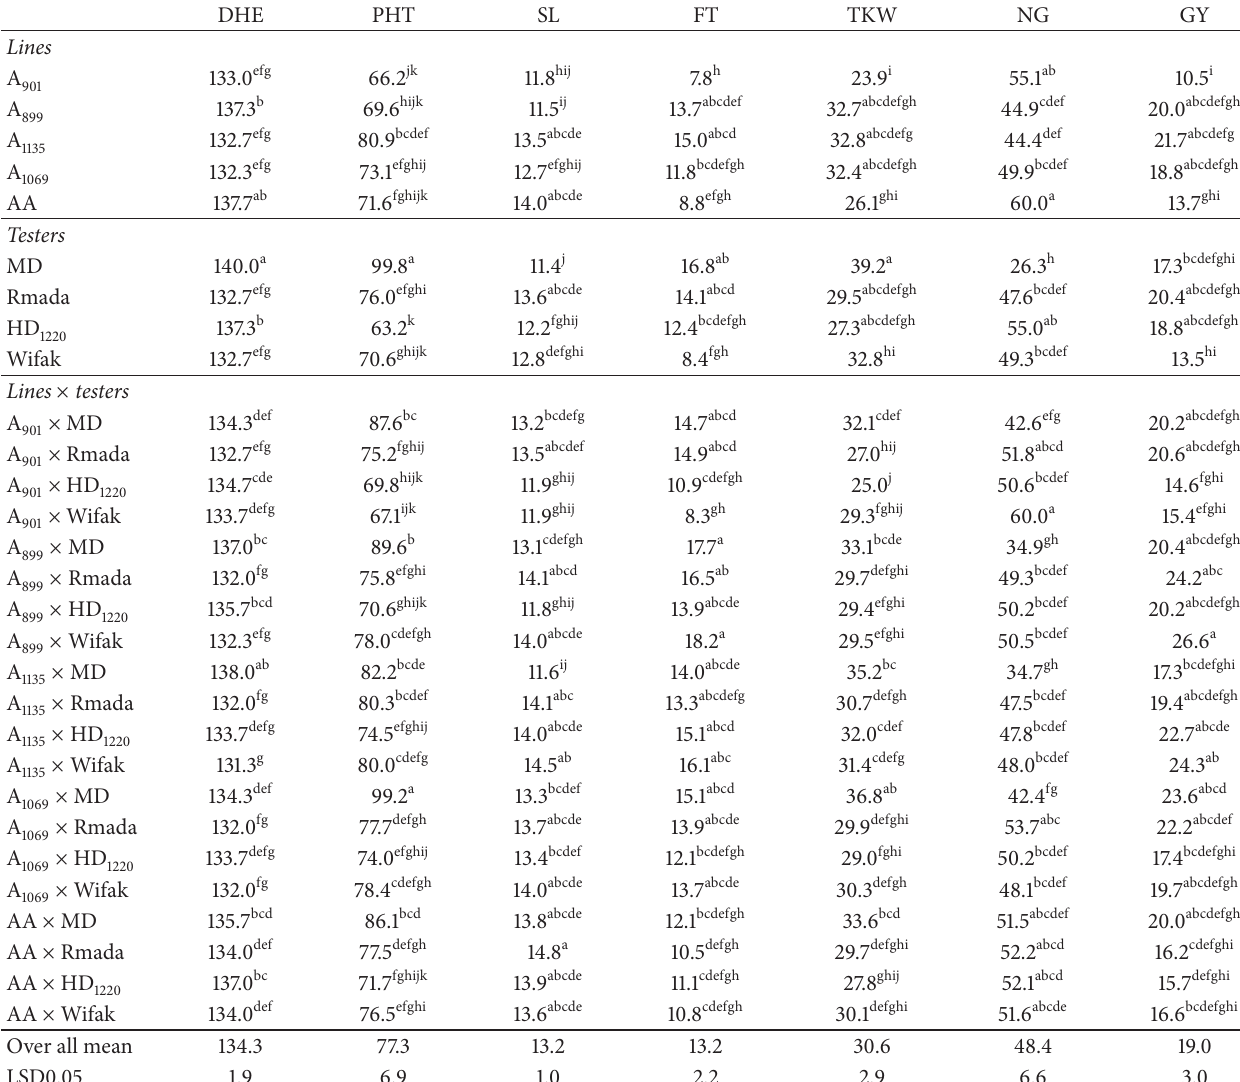
Table 3: Means of the measured characters for 9 bread wheat parents and their 20 F